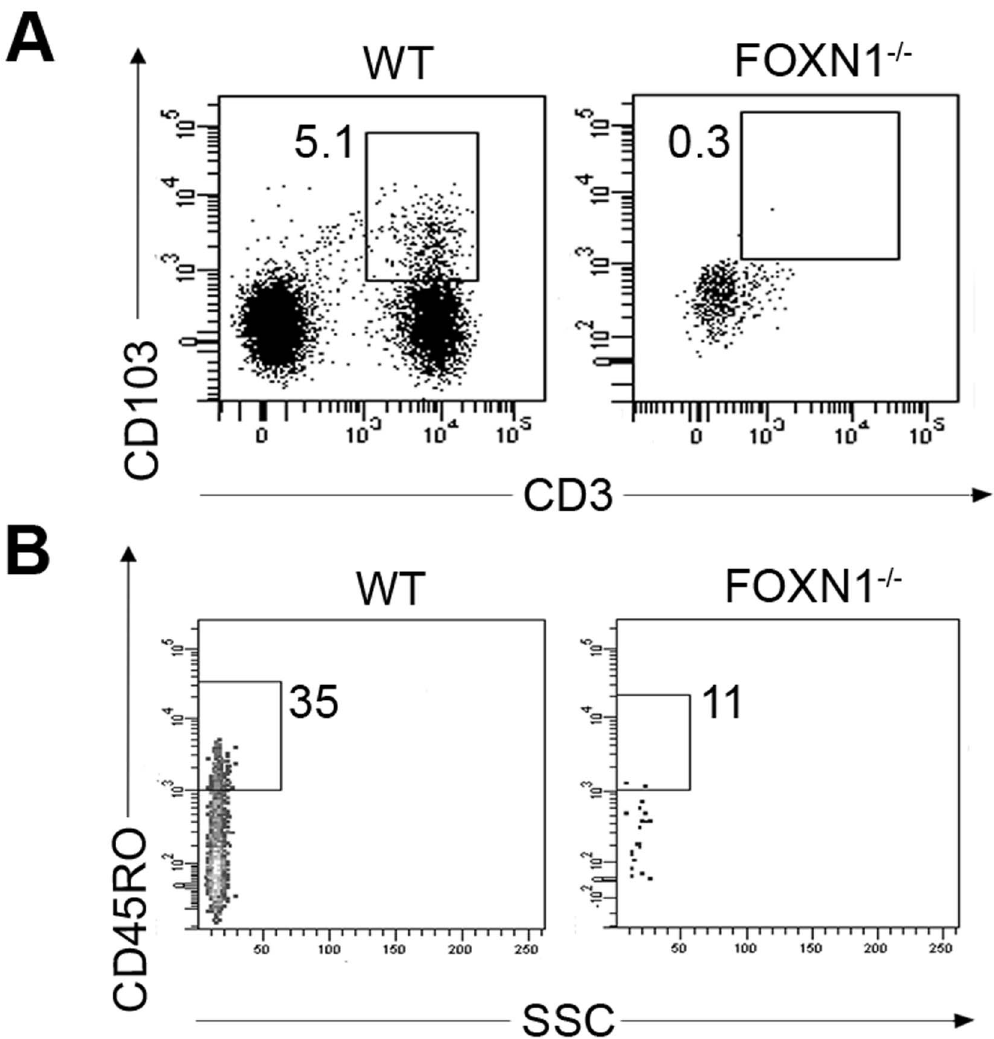
Figure 5. Expression on T lymphocytes from FOXN1 2 / 2 and control fetuses of the integrin CD103 and the CD45RO activation marker. (A, B) Flow cytometry of CBMCs from normal and FOXN1 2 / 2 fetuses matched for gestational age (16 weeks of gestations). Dot plots show the frequency of CD103 + CD3 + on CD45 + gated CBMCs (A) and CD45RO + on CD3 + gated CBMCs (B).